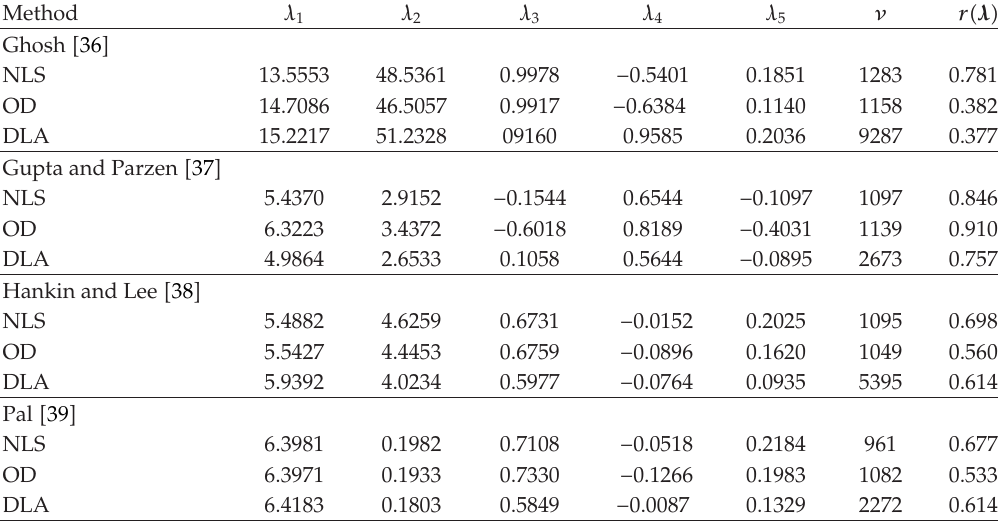
Table 3: Comparison of FPLD